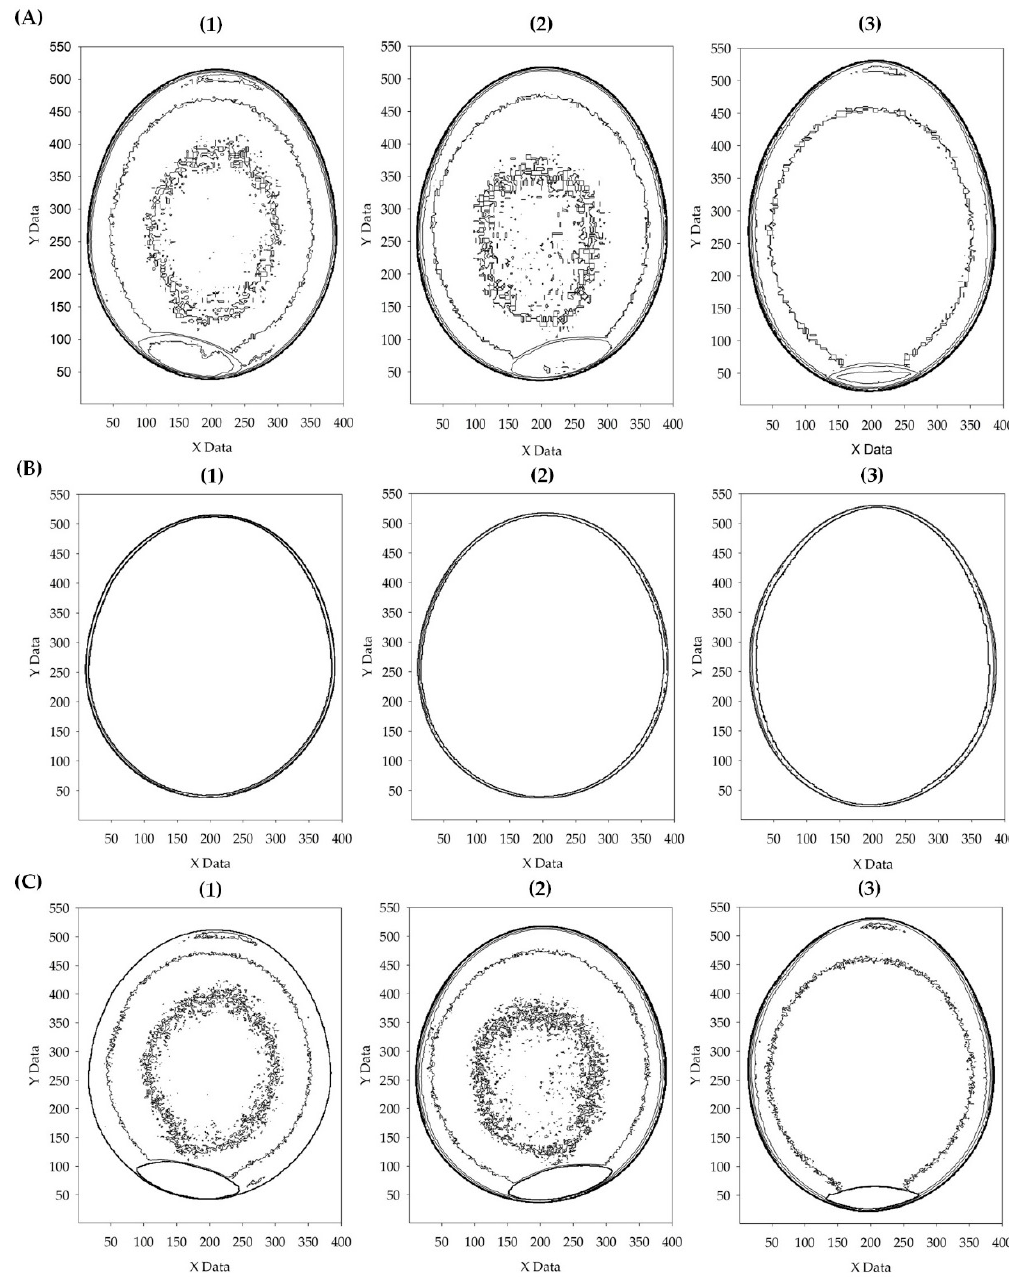
Figure 3. Diagrams of stratification analysis of median plane imaging data of eggs analysis. The X- and Y-axes are the count matrix gray-scale units. The figure shows eggs of three different qualities: (1) SO eggs, (2) GO eggs, and (3) CO eggs. Diagrams of the different stratification analysis of ( A ) the whole egg, ( B ) shell, and ( C ) inner part of the egg are rendered after a stratification analysis of the visualization.